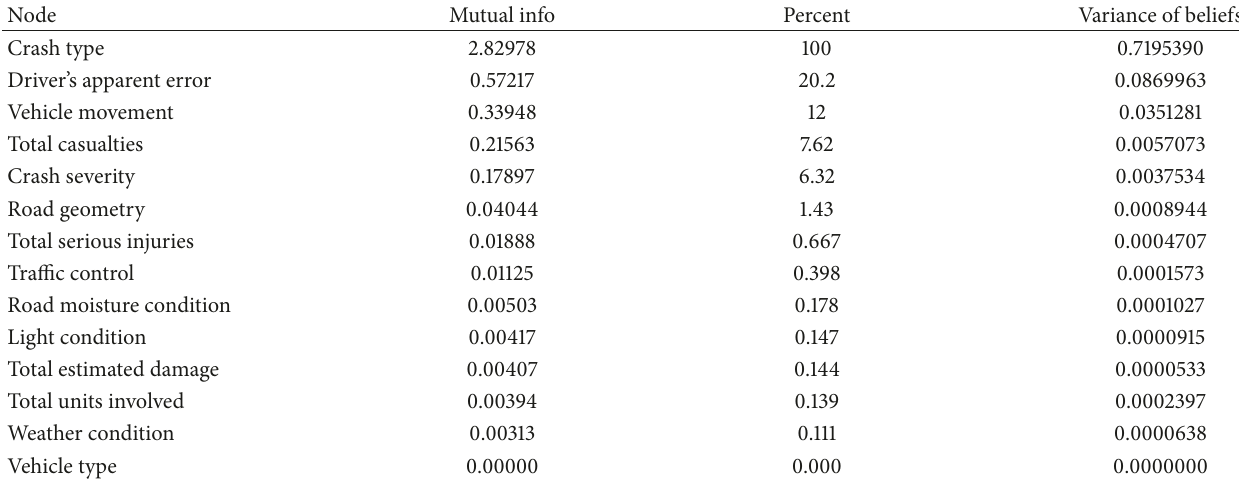
Table 3: Sensitivity analysis result of the node “crash type.”